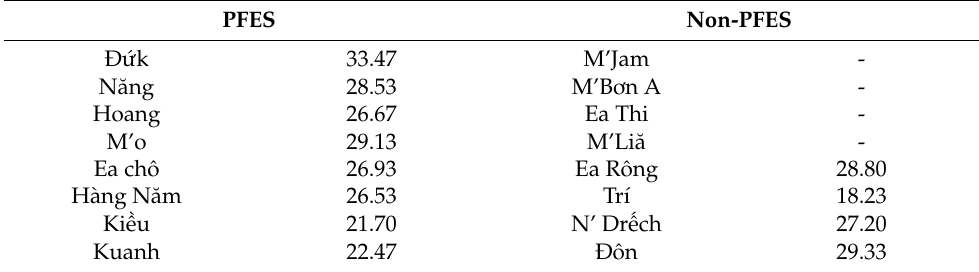
Table 8. Average patrol days per year in study sites.